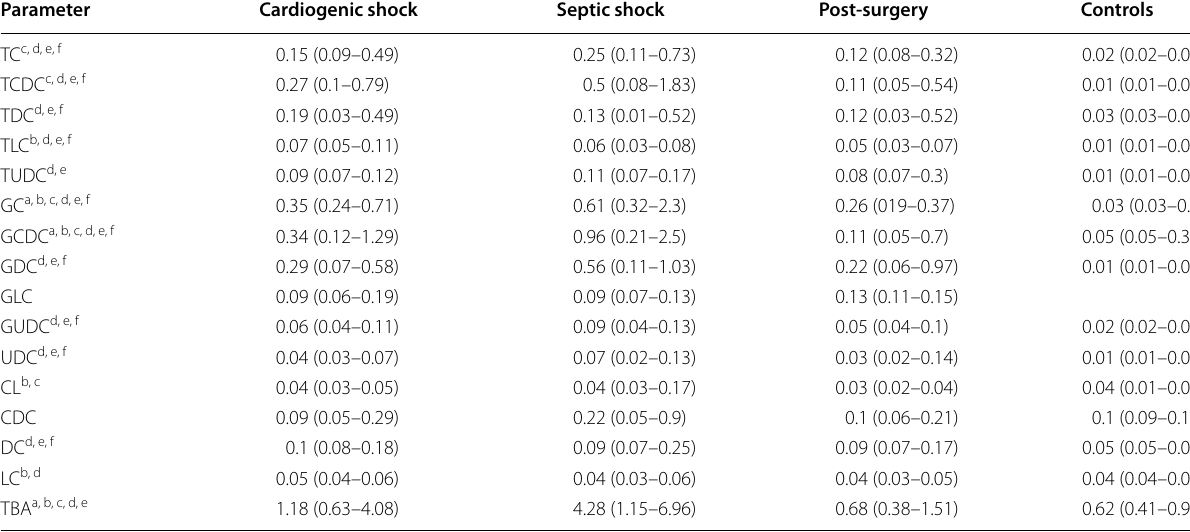
Bile acids on admission are shown as median and IQR; bile acids (μmol/l) TC taurocholic acid, TCDC taurochenodeoxycholic acid, TDC taurodeoxycholic acid, TLC taurolithocholic acid, TUDC tauroursodeoxycholic acid, GCDC glycochenodeoxycholic acid, GC glycocholic acid, GDC glycodeoxycholic acid, GLC glycolithocholic acid, GUDC glycoursodeoxycholic acid, UDC ursodeoxycholic acid, CL cholic acid, CDC chenodeoxycholic acid, DC deoxycholic acid, LC lithocholic acid, TBA total bile acids